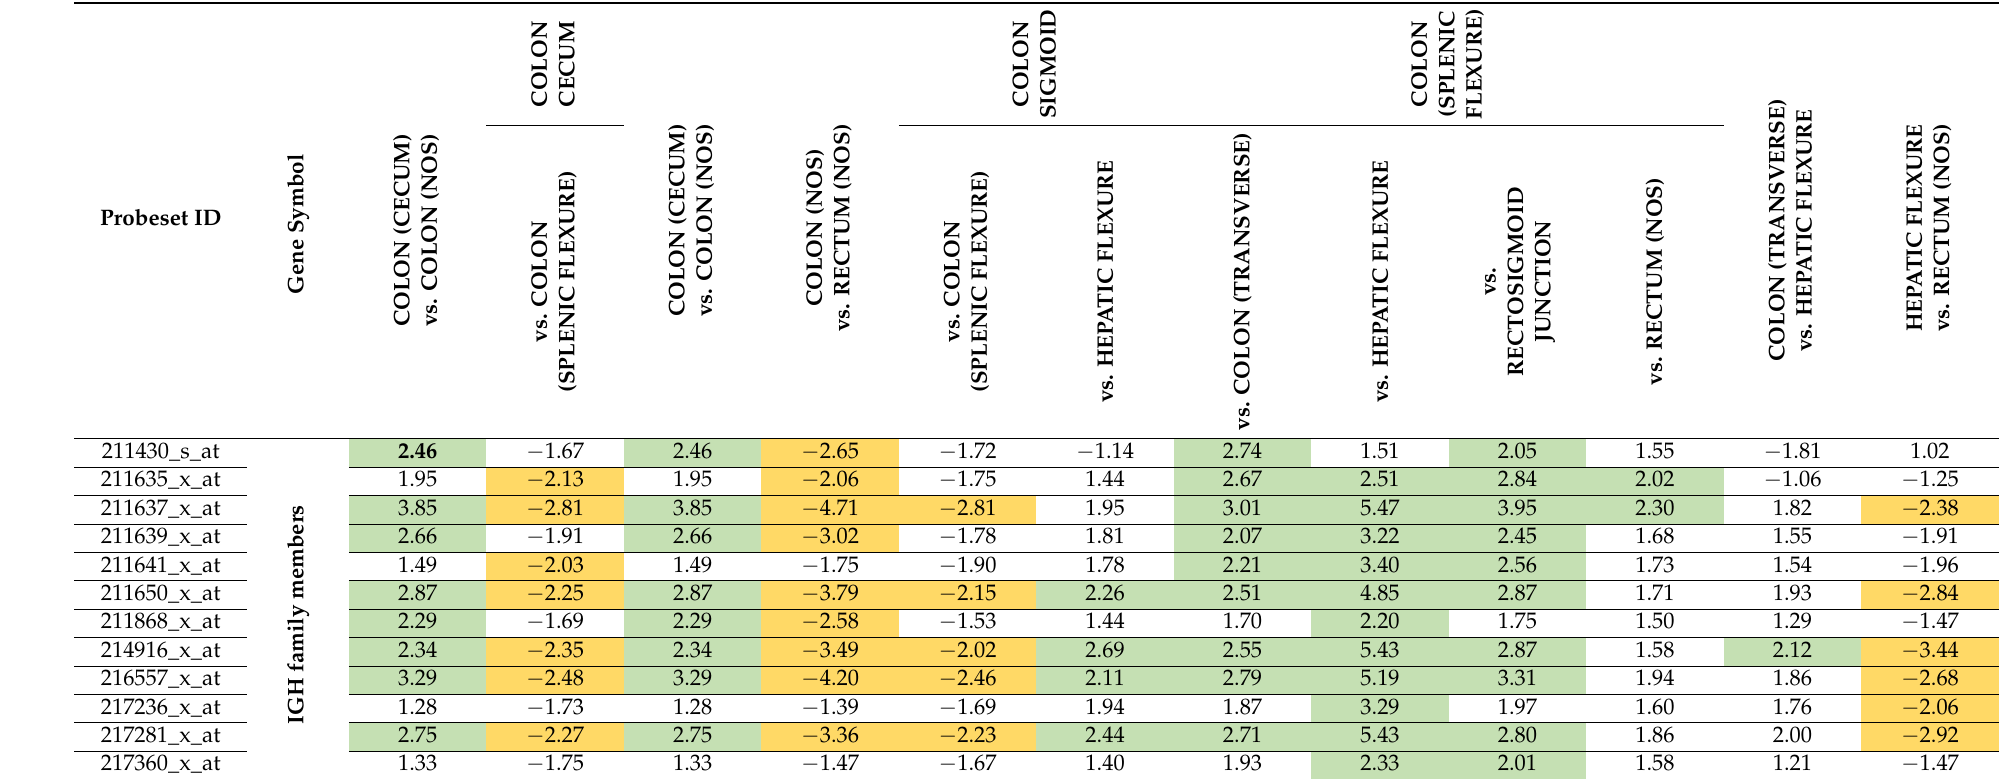
Table 8. Fold change in antigen transcript levels that achieved significance, when comparing collection sites including colon (cecum, nos, splenic flexure, sigmoid, transverse) and rectum (nos). Light green cells indicate values that are increased by greater than 2-fold, yellow cells indicate values that are decreased by greater than